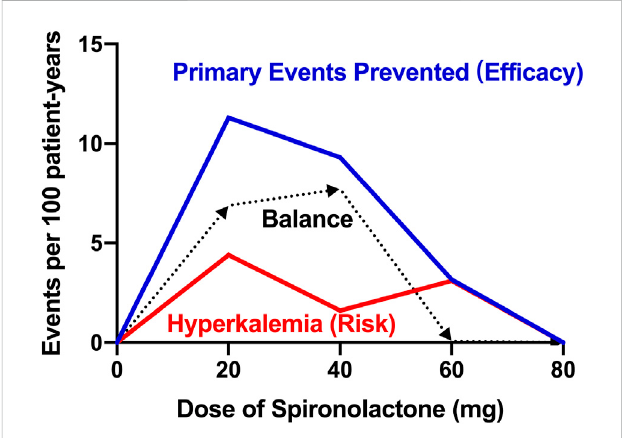
Title: Balance of ef fi cacy and risk of spironolactone Legend: Balance difference between ef fi cacy and safety of different doses of spironolactone. Ef fi cacy is de fi ned as the treatment effect on the prevented primary endpoint (all-cause death, heart failure hospitalization, or stroke). Risk is de fi ned as the risk of hyperkalemia (serum potassium > 5.5 mmol/L). Balance is de fi ned as the